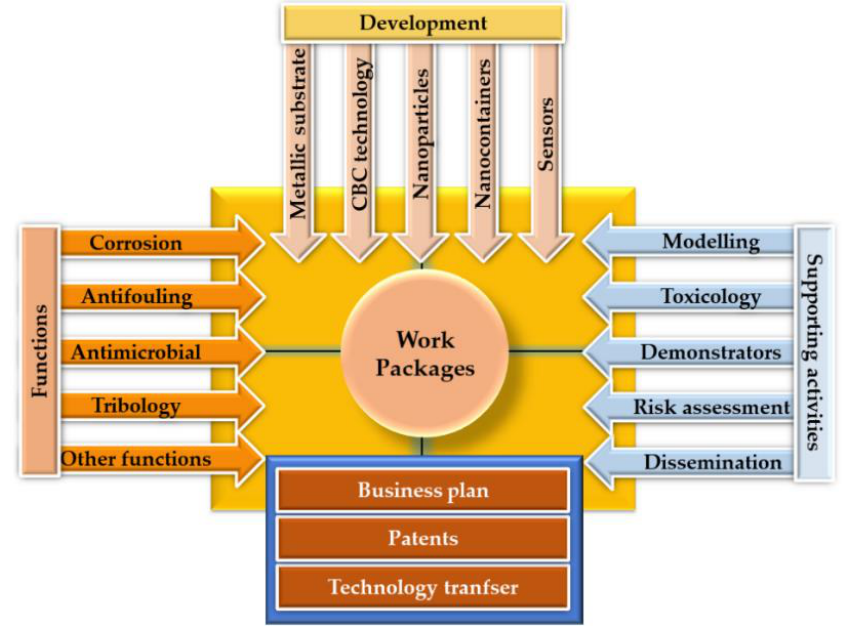
Figure 13. The basic structure of CBC development: from lab to industry.